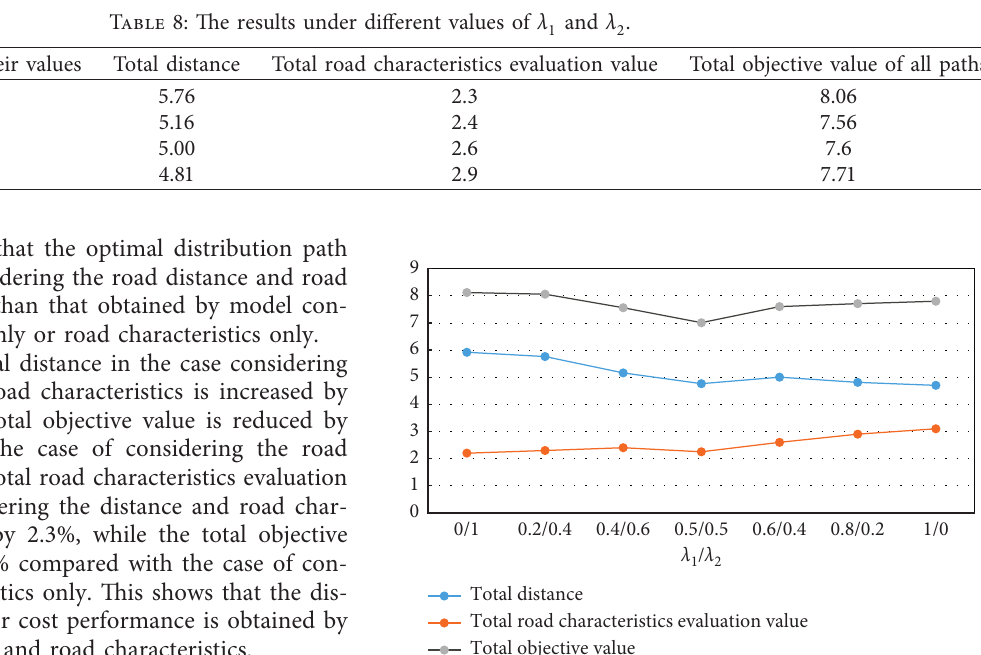
Table 7: Distribution paths and related results in the case of λ